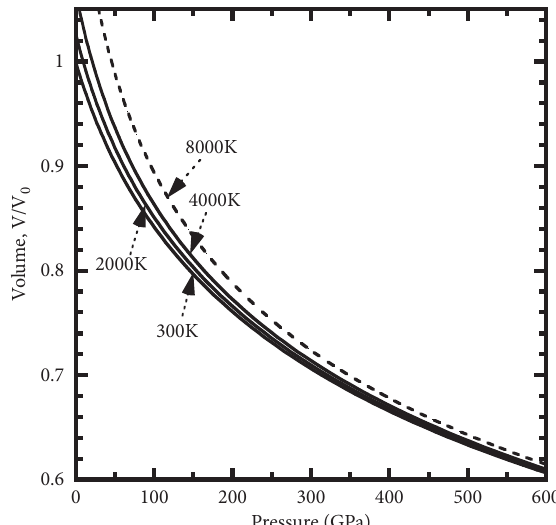
Figure 5: Change in the isothermal volume of Re. Solid lines are the calculated isotherms at 300, 2000, and 4000K using equation (4) and the parameters in Table 1. Dashed line represents the explored isotherm at 8000K.